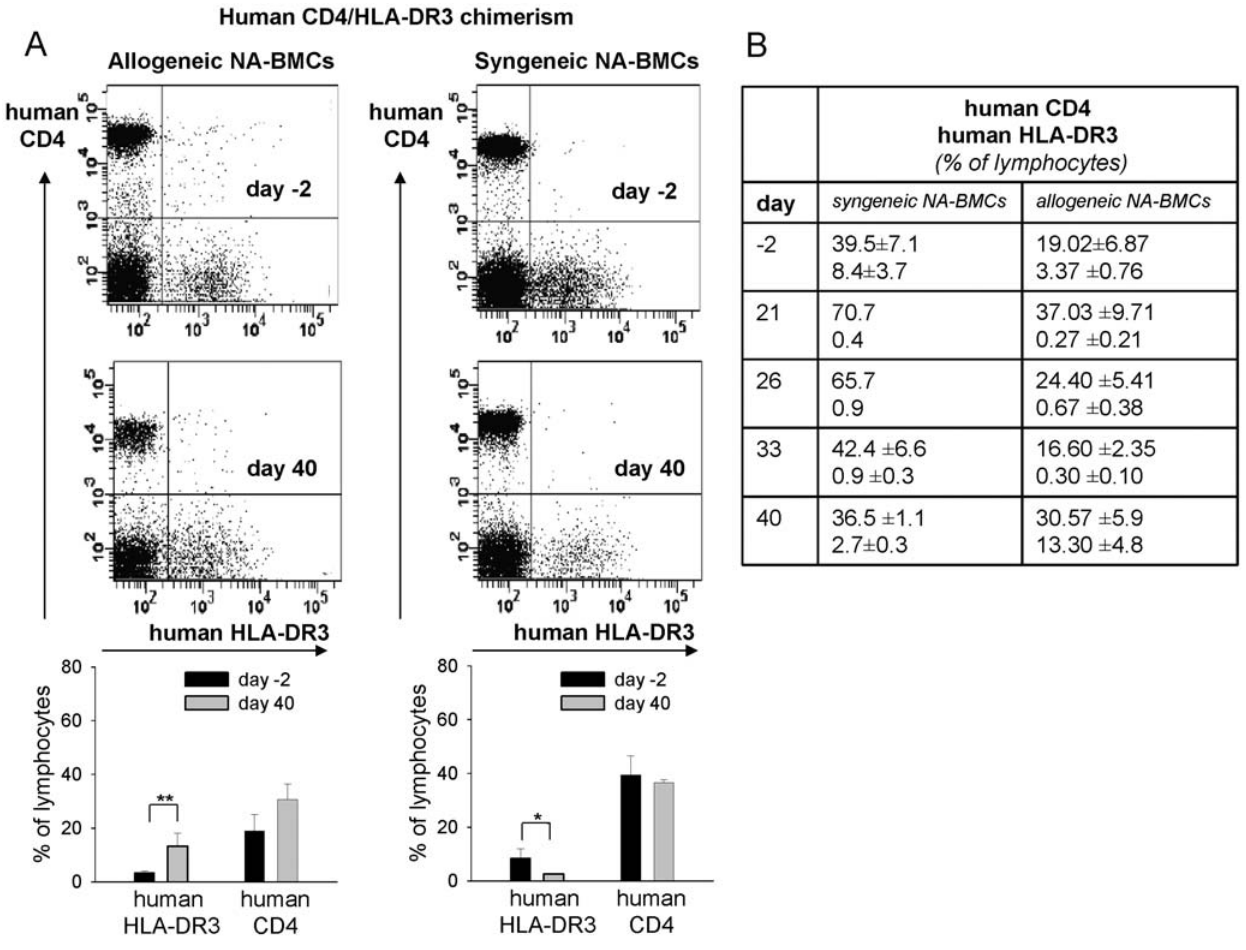
Figure 6. Flow cytometry analysis of human CD4/HLA-DR3 (gated for lymphocytes) from peripheral blood on day -2 before and day 40 after transplantation. Data are shown for transplantation of allogeneic and syngeneic NA-BMCs (A). Human CD4 molecules were stable expressed from day 21 after transplantation until the end of the experiment whereas human HLA-DR3 molecules were not expressed until day 40 (B).